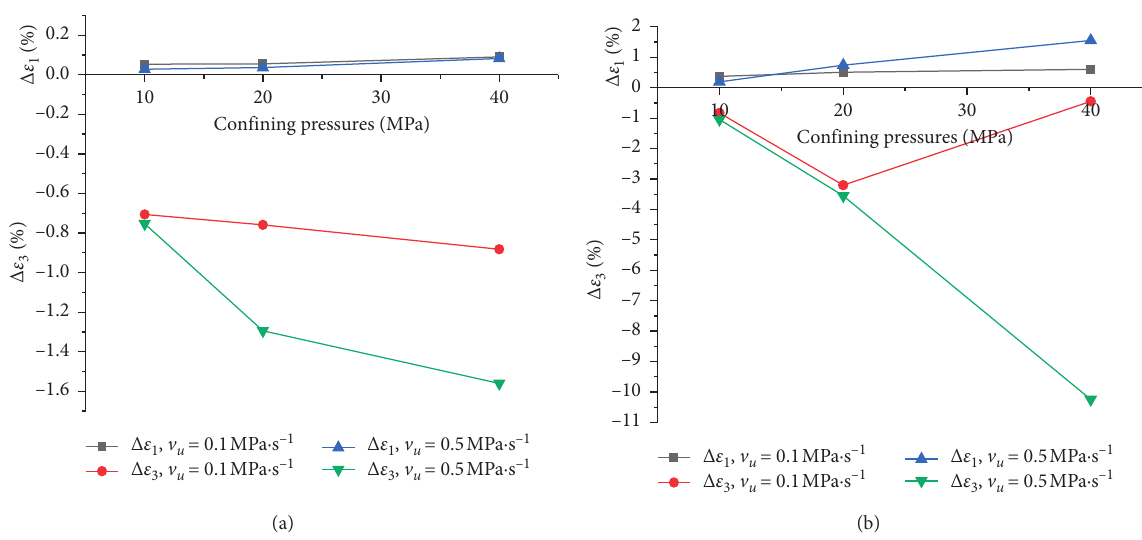
Figure 7: Affection laws of strain increment in the unloading triaxial test: (a) unloading starting point to the peak strength stage; (b) peak strength to the residual strength stage.